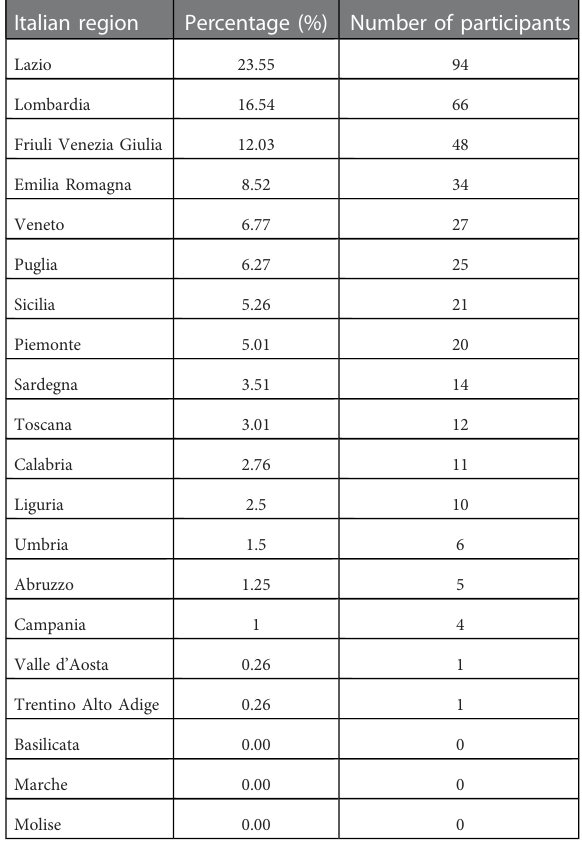
TABLE 3 Italian regions in which the respondents work ( n =399